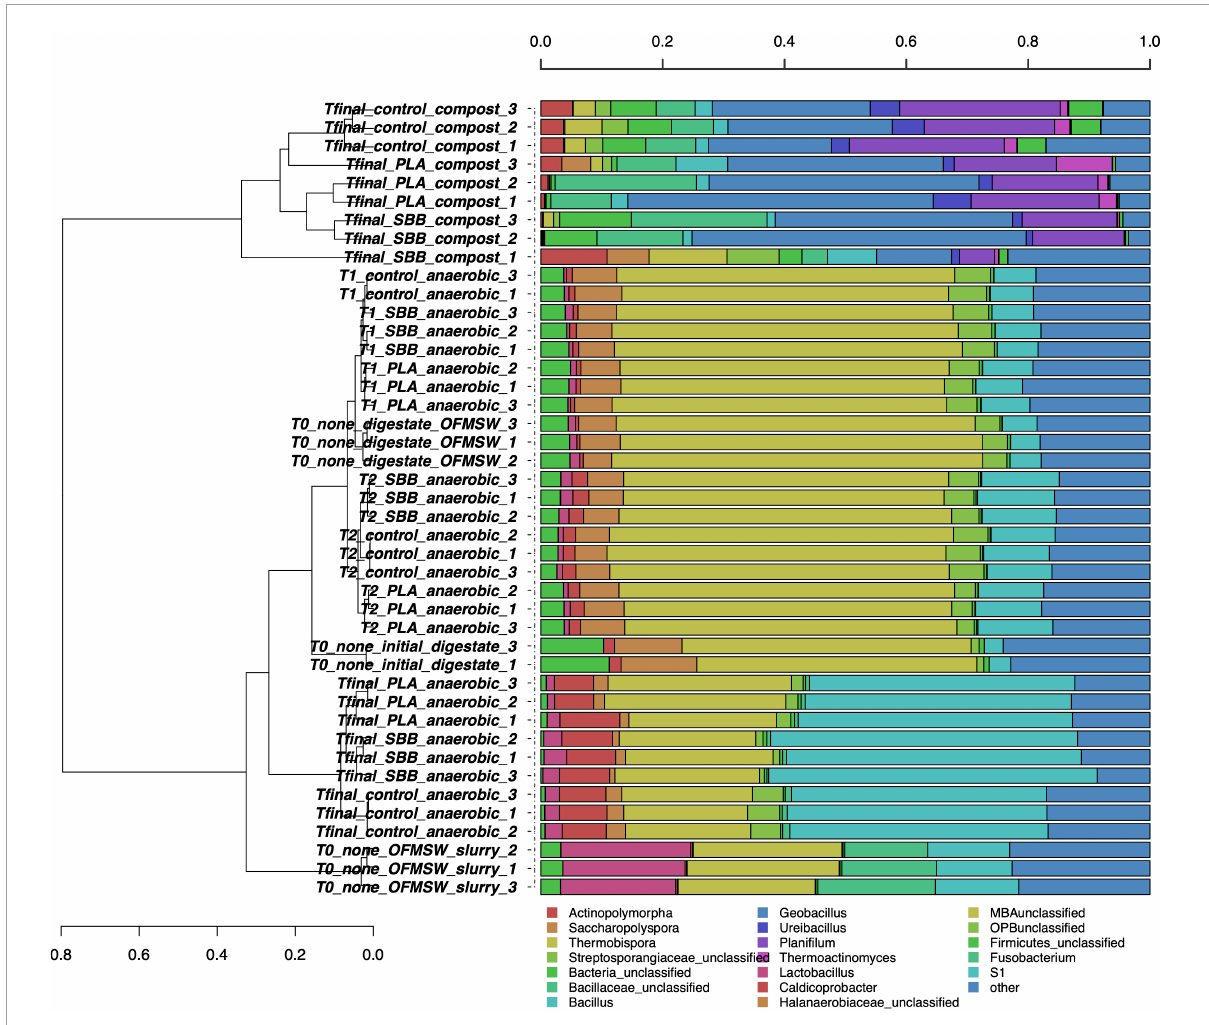
FIGURE1 Hierarchical clustering of bacterial sequences using the average linkage algorithm at the genus level for taxa with at least ≥ 5% participation in a single sample. Taxa with low contributions were added to the “other” group. PLA, polylactic acid; SBB, starch-based bioplastic; OFMSW, organic fraction of municipal solid